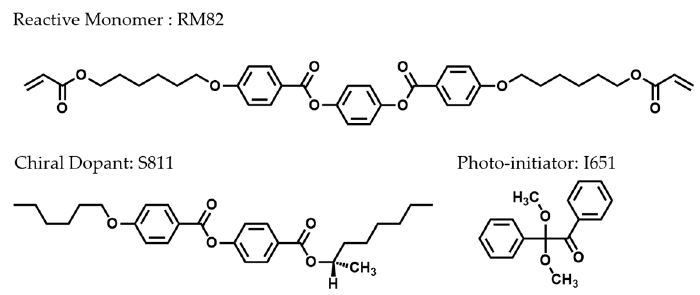
Figure 1. The molecular structures of RM82, S811, and Irgacure-651.